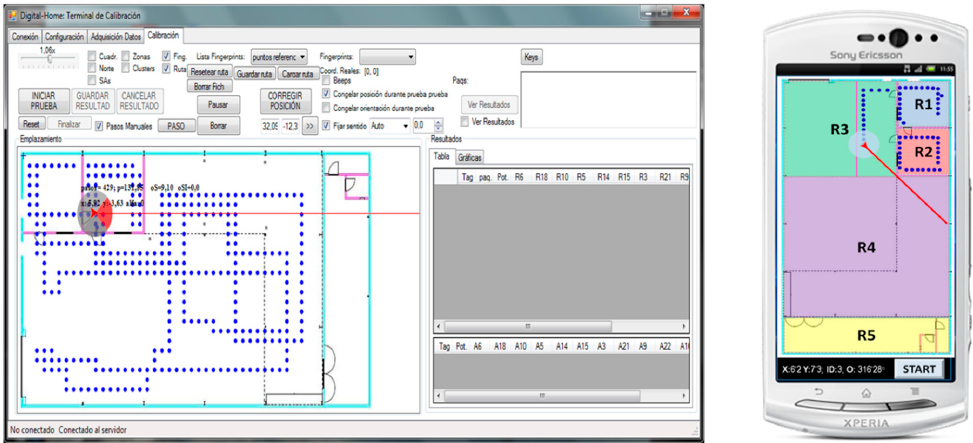
Figure 3. ( Left ) System management tool and ( Right ) site survey tool for Android.